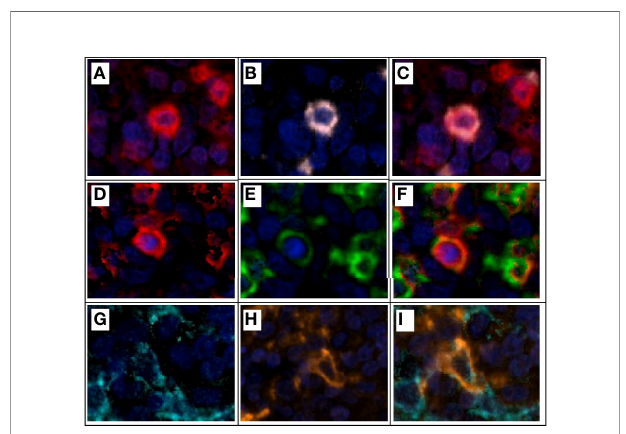
FIGURE 7 | Multiplex immuno fl uorescence and colocalization examples. (A) CD3+ expression (red) on a lymphocyte T. (B) CD8+ expression (pink) of the same lymphocyte T in example (A) . (C) CD3+ and CD8+ expression and colocalization (red and pink) for a cytotoxic T lymphocyte. (D) CD3+ expression (red) on a lymphocyte T. (E) PD1+ expression (green) of the same lymphocyte T in example (D) . (F) CD3+ and PD1+ expression and colocalization (red and green) for a T lymphocyte PD1+. (G) Cytokeratin+ expression (cyan) of an epithelial tumor cell. (H) PDL1+ expression (orange) of the same epithelial tumor cell on example (G) . (I) Cytokeratin+ and PDL1+ expression and colocalization (cyan and orange) on an epithelial tumor cell expressing PDL1 on its surface for immune evasion. Composite image from inform ® image analysis software, Akoya bioscience. Scanner Vectra